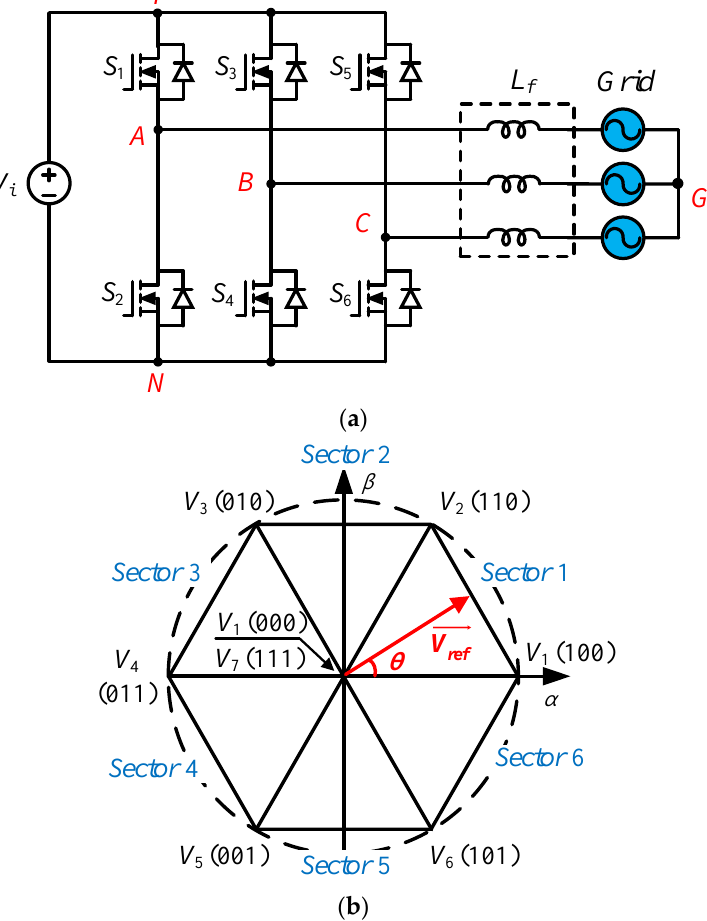
Table 1. Common-mode voltage of traditional H6 topology.